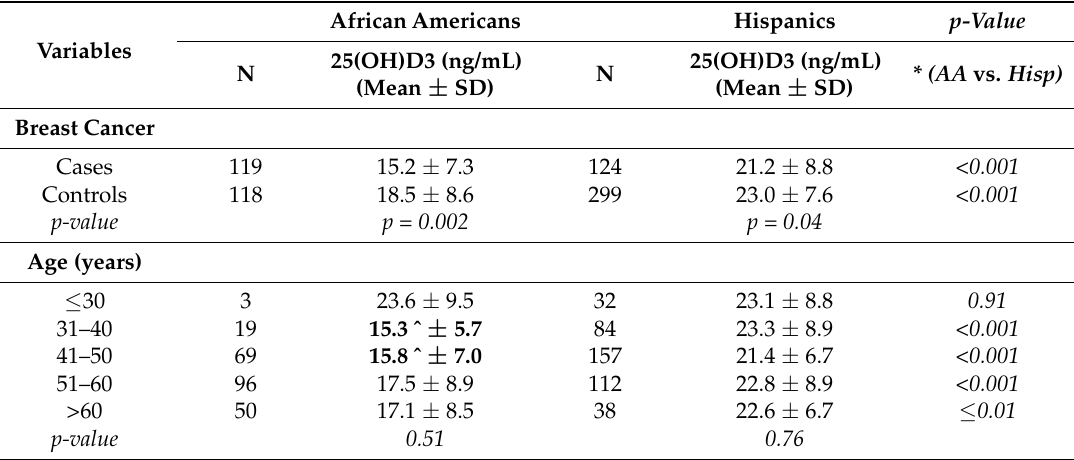
Table 2. 25(OH)D3 level by